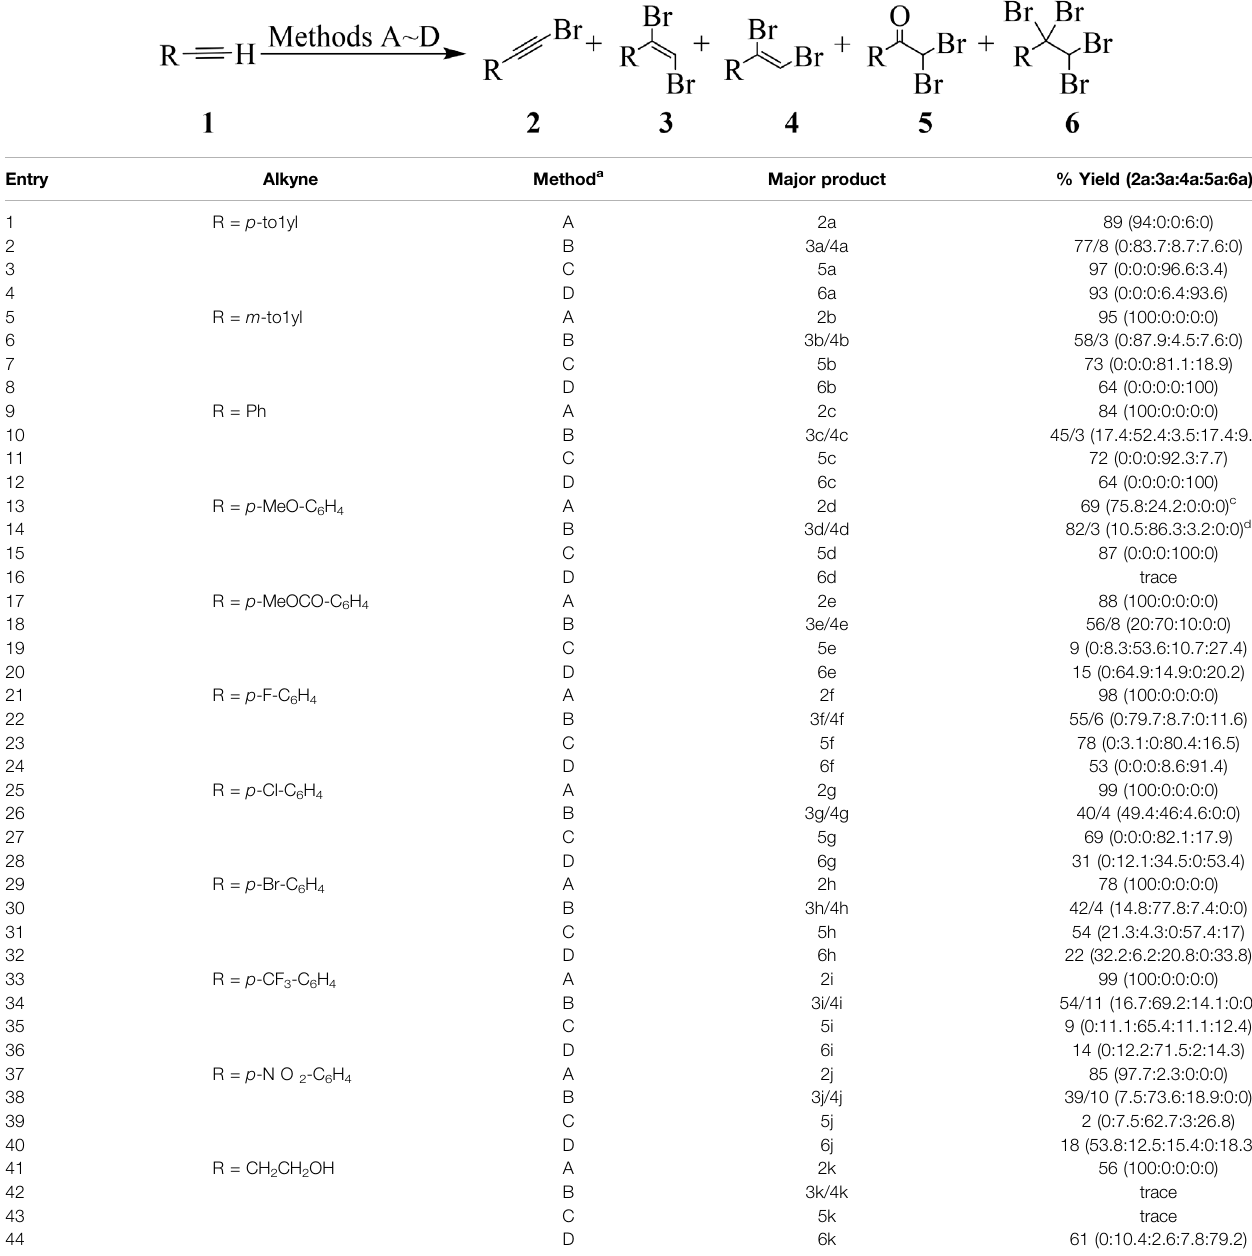
TABLE 3 | Selective bromination of terminal alkynes with hypervalent iodine